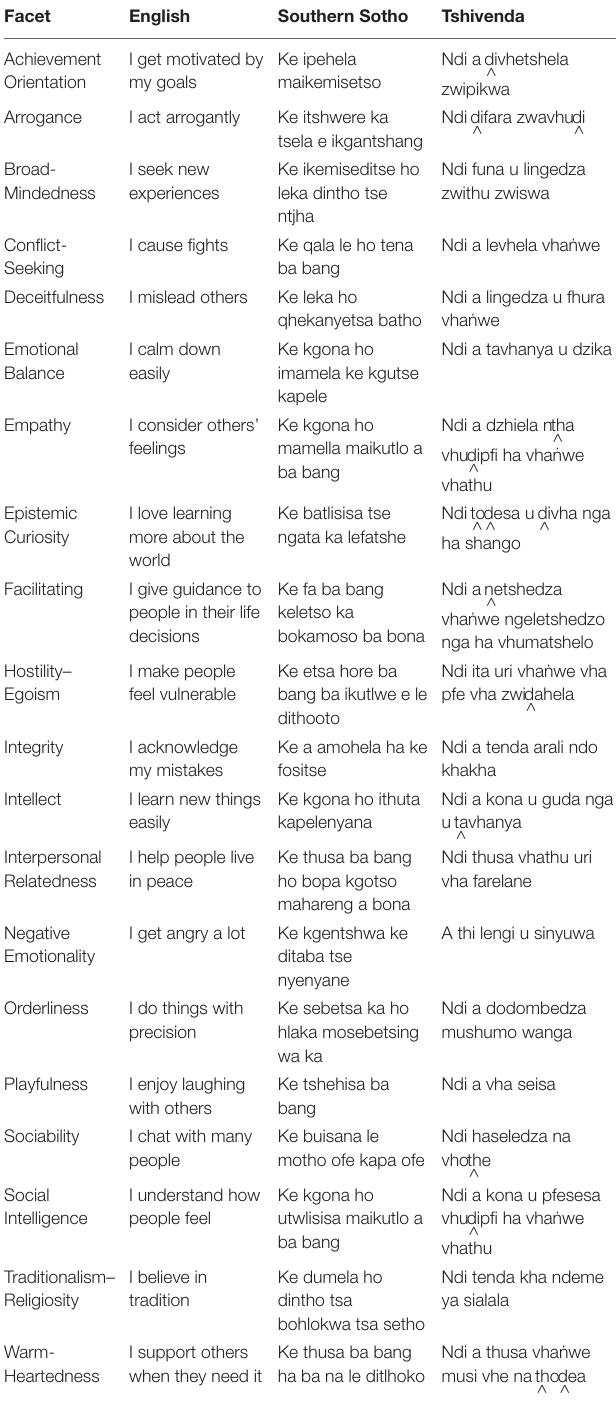
TABLE 3 | Examples of paraphrased items for the different language